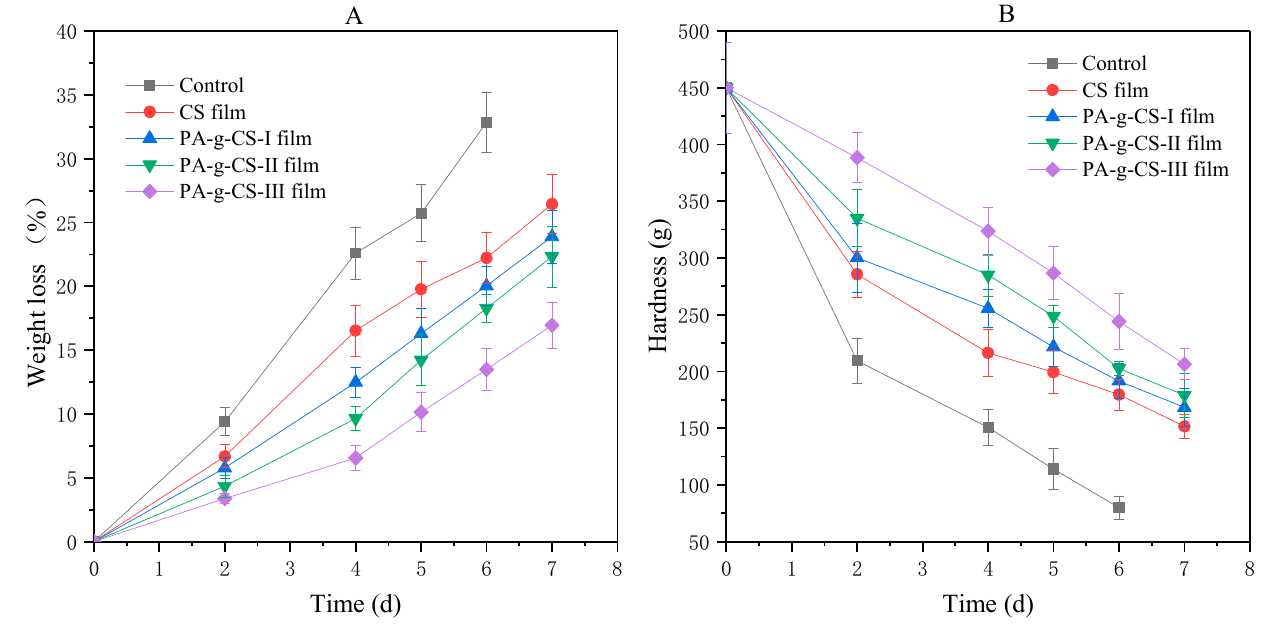
Figure 8. The changes in loss ( A ) and hardness ( B ) of fresh-cut jackfruit.